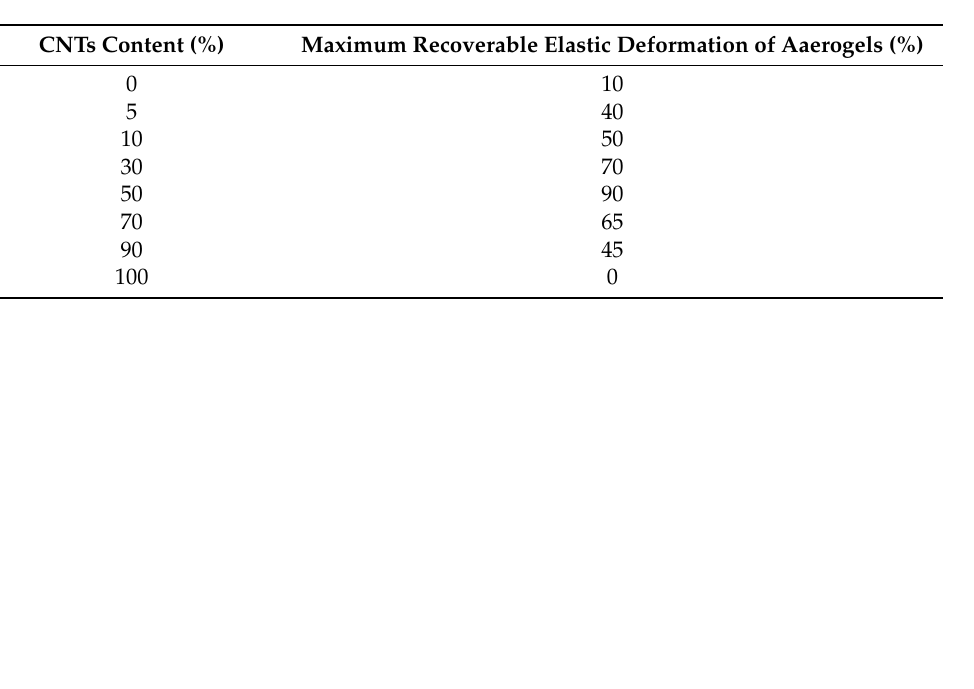
Table 1. Maximum recoverable elastic deformation of aerogels with different CNTs